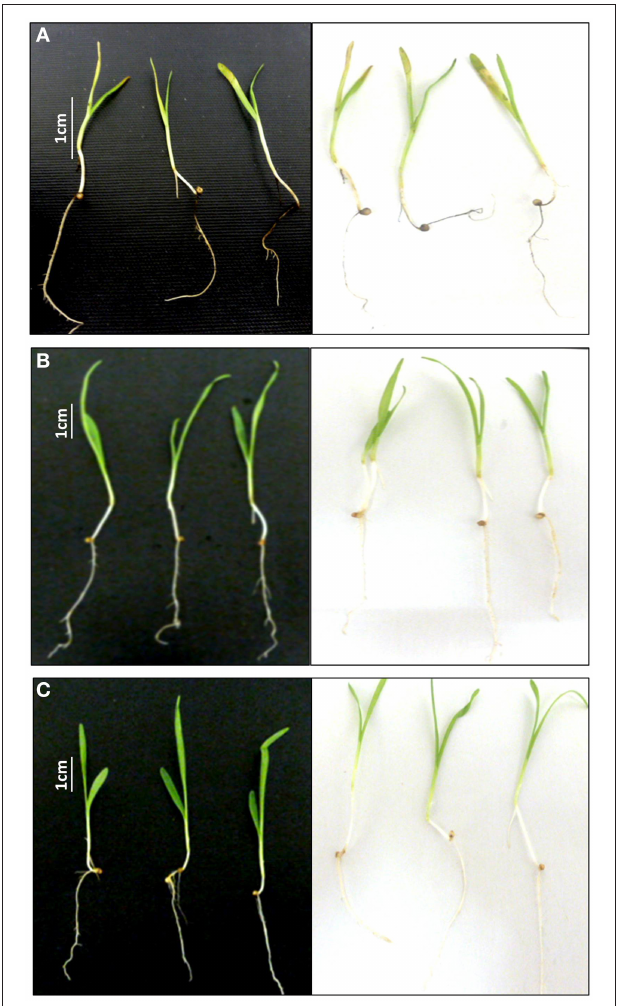
FIGURE 2 | Testing the pathogenicity of the putative endophyte WF4 on finger millet. (A) Representative pictures showing the effect of the known pathogen Alternaria alternata on finger millet seedlings (negative control). (B) Representative pictures showing the effect of buffer on finger millet seedlings (positive control). (C) Representative pictures showing the effect of the fungus WF4 on finger millet seedlings.